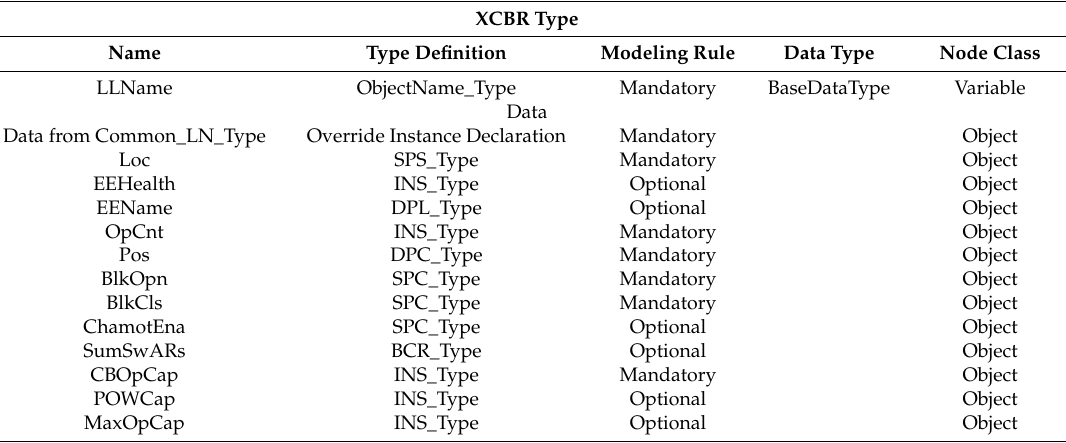
Table 4. Example of logical node: XCBR mapping.